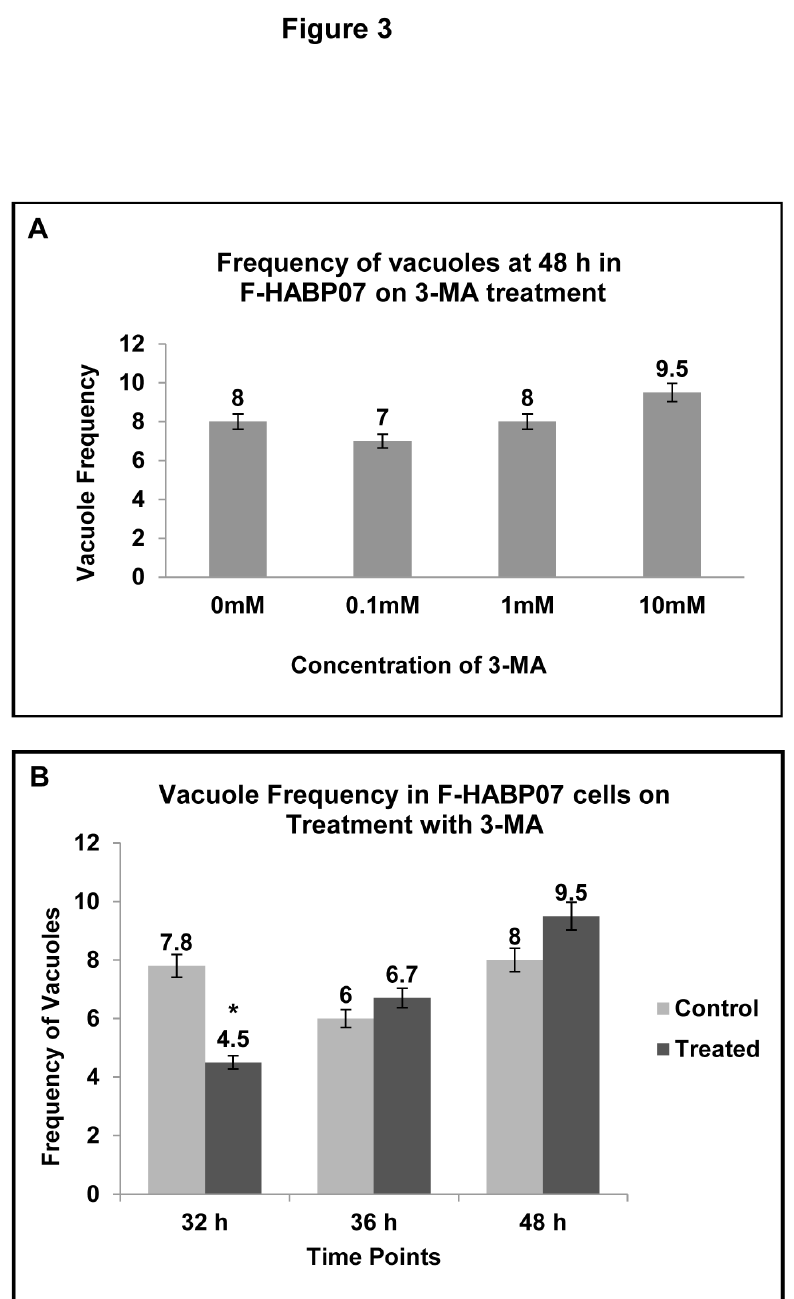
Figure 3. Vacuole Frequency is affected at 32 h upon 3-MA treatment in a time dependent manner. [A] Concentration independent occurrence of vacuoles in F-HABP07 at 48 h -- Vacuole Frequency counted in F-HABP07 at 48 h after treatment with varying concentration of 3-MA (0mM, 0.1mM, 1mM and 10mM) and H-E staining depicted in the histogram after counting the number of vacuolated cells out of the total cells in 10 sites and then calculating the vacuole frequency per 100 cells. Single factor one-way statistical analysis of variance carried out using ANOVA software, with difference at a level of * p ≤ 0.05 between groups considered as statistically significant, indicated insignificant change in the vacuole frequency upon the aforementioned treatment. [B] Reduction of vacuole frequency upon treatment at 32 h-- Vacuole frequency in F-HABP07 counted after treatment with PI3 kinase inhibitor 3-MA and then H-E staining, as mentioned before, shows that it is effective in reduction of vacuole formation at 32 h by almost 40% and not beyond that time point. The change in vacuole frequency at 32 h upon treatment with 3-MA was found to be significant and has been indicated in the figure [ * ]. doi: 10.1371/journal.pone.0078131.g003 PLOS ONE |